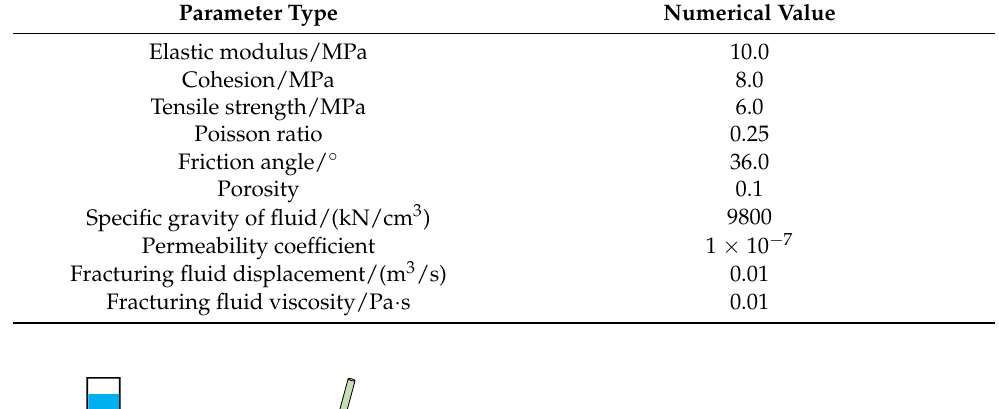
Table 2. Physical and mechanical parameters.